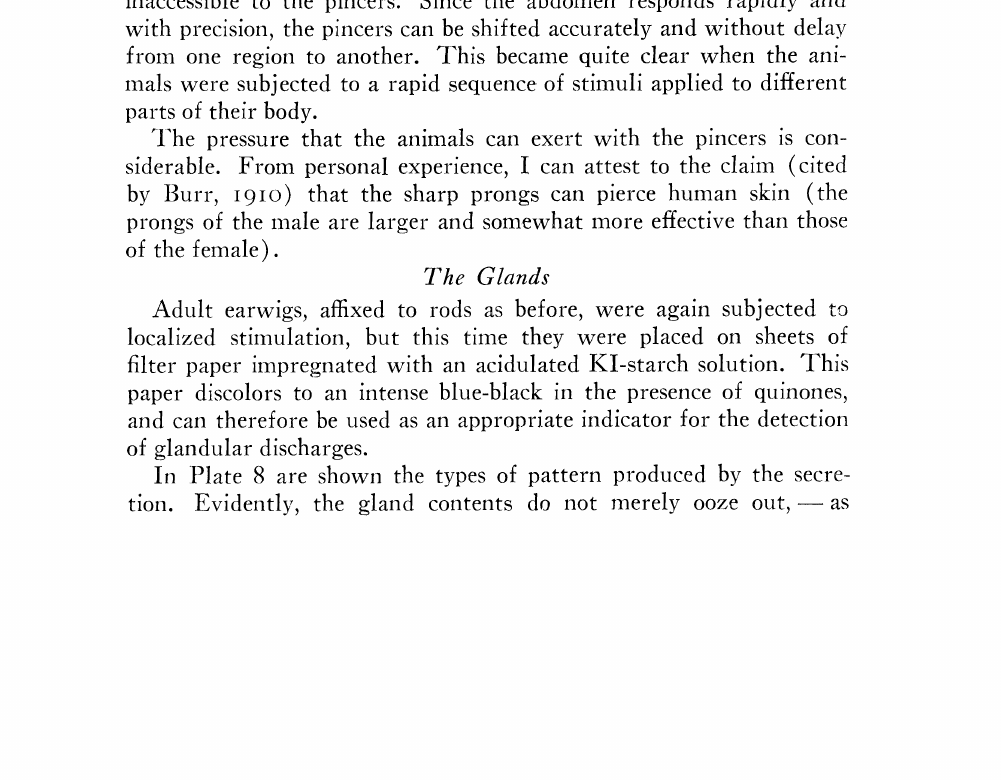
Text Figure 1. Forficula auricularia Linn. showing the four glandular openings and the cuticular sculpturing around them on the third and fourth abdominal